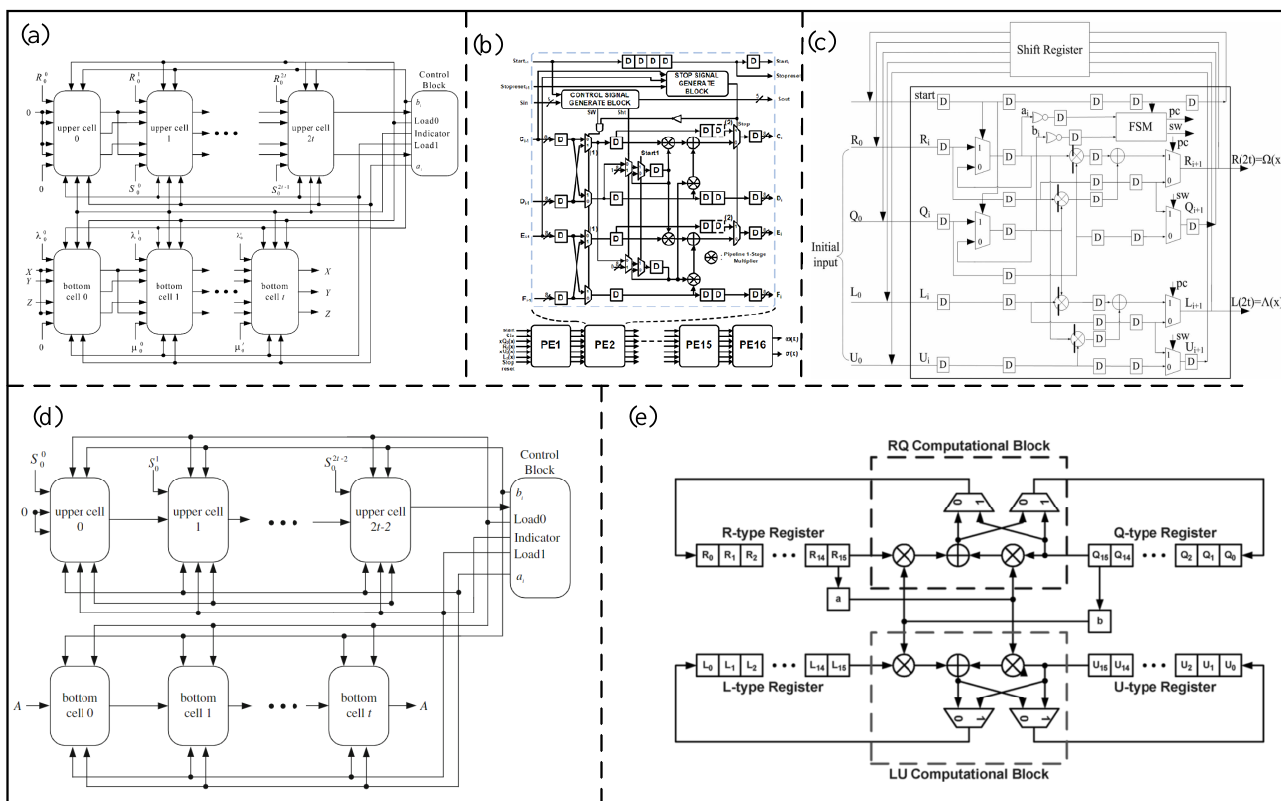
Figure 12. ( a ) Proposed DCME architecture. (Reprinted from [81], Copyright 2006, with permission from IEEE). ( b ) Block diagram of DCME algorithm. (Reprinted from [82], Copyright 2007, with permission from IEEE). ( c ) Block diagram of RDCME algorithm. (Reprinted from [83], Copyright 2009, with permission from IEEE). ( d ) New SE algorithm. (Reprinted from [84], Copyright 2013, with permission from IEEE). ( e ) Proposed Jit − FMEA algorithm. (Reprinted from [85], Copyright 2004, with permission from IEEE).